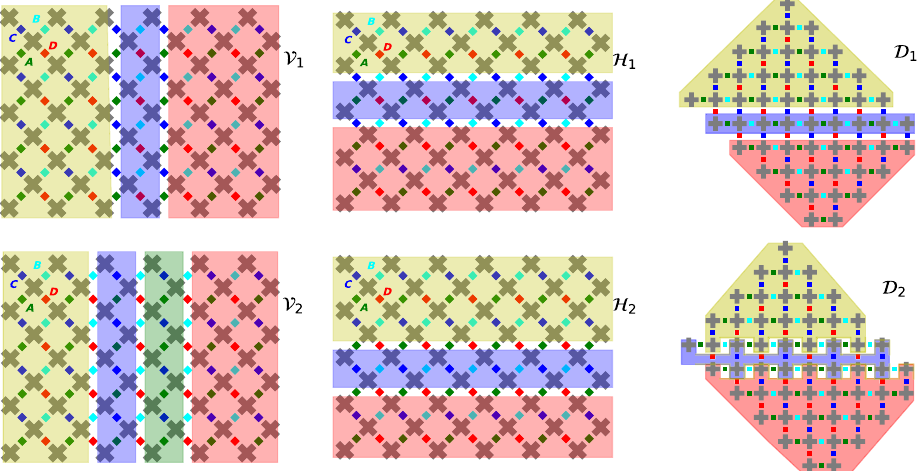
FIG. 7. Different qubit groupings used in our simulation. All qubits shaded with the same color (yellow, blue, green, or red) belong to the same tensor M (τ)